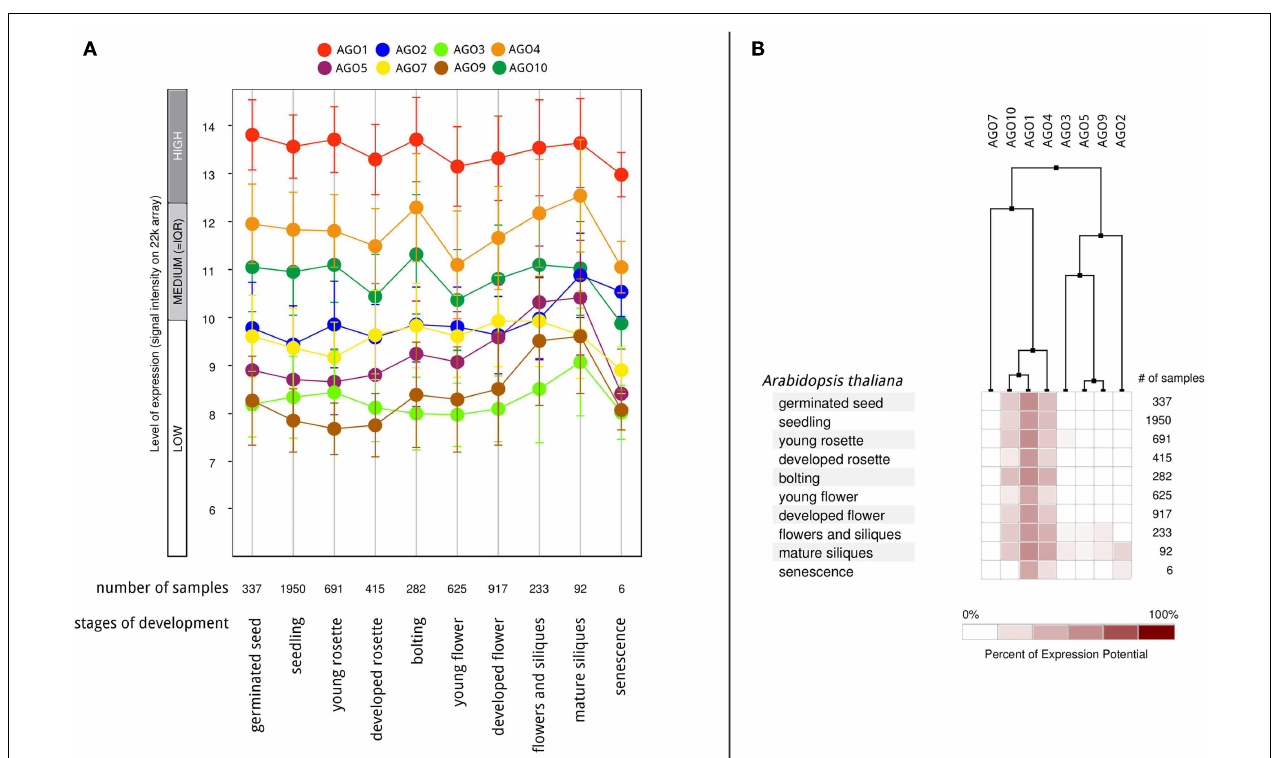
FIGURE 6 | DifferentialAGO expression in different stages of A. thaliana development based on Genevestigator microarray data. (A) The level of AGO expression (log 2 -scale) at different stages of development and (B) hierarchical clustering on the developmental expression